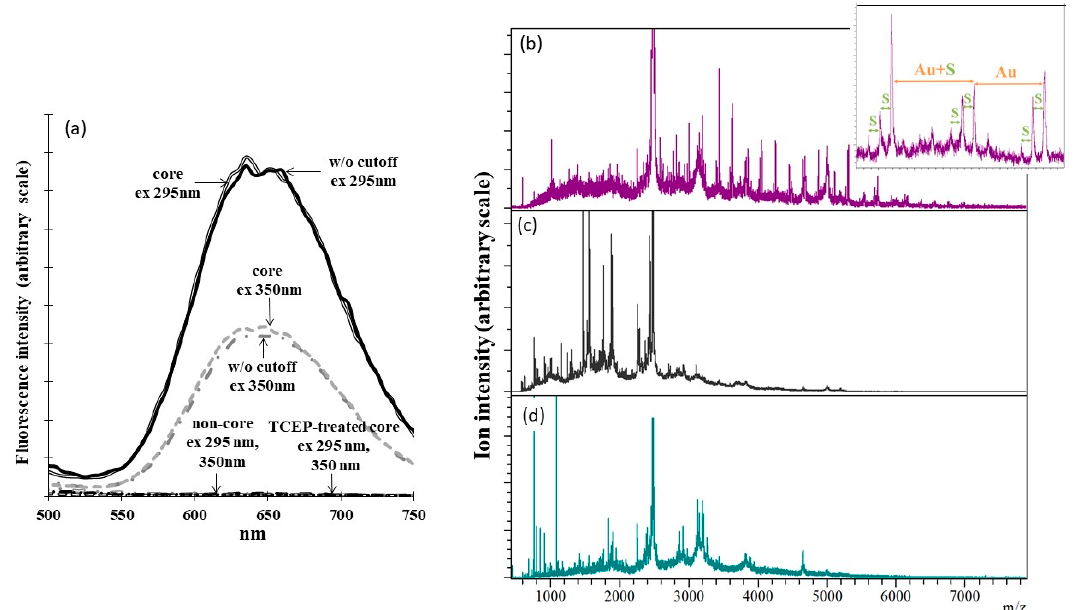
Figure 3. ( a ) Fluorescence of the native-digested BSA-AuNCs (w/o cutoff) and its core and non-core fraction separated using 10 kDa-cutoff membrane, as well as its disulfide-cleaved (by TCEP) core fraction excited at 295 nm or 350 nm. [Au n S m ] signals in the low-mass region of MALDI-MS detected from the ( b ) core and ( c ) non-core fraction of native-digested BSA-AuNCs, as well as ( d ) disulfide-cleaved (by TCEP) core fraction. The spectra pattern of ( b ) was enlarged in the inset. Base peak chromatograms (BPC) constructed by the strongest peptides at each elution time (Figure 4a) indicated that the core fraction mainly consisted of peptides containing non-oxidized cysteine residues. In contrast, the non-core fraction mainly consisted of peptides which do not have